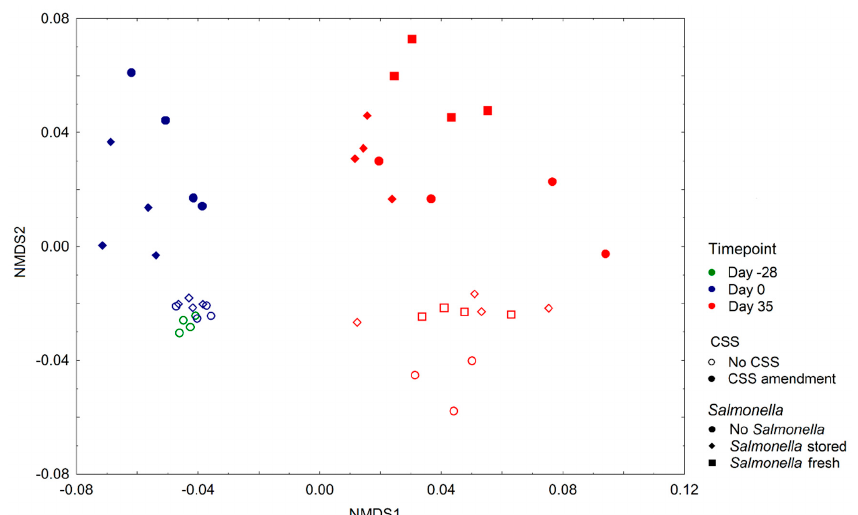
Figure 3. Beta diversity between the prokaryotic communities in diluvial sand (DS) soil. The non-metric multidimensional scaling (NMDS) analysis of the microbial community and analysis of similarities (ANOSIM) were performed according to the sampling timepoint (green: mixing day, blue: planting day, red: 35 days after planting). [ANOSIM] R: 0.85035; p -value < 0.001, [NMDS] stress = 0.096213, sludge amendment (empty: without sludge, solid color: sludge amended) [ANOSIM]. R: 0.36323; p -value < 0.001, [NMDS] stress = 0.096213 and Salmonella enterica presence (circles: no Salmonella enterica , diamonds: Salmonella enterica introduced via fertilizer, squares: Salmonella enterica introduced via irrigation) [ANOSIM]. R: 0.095536; p -value < 0.036, [NMDS] stress = 0.096213. p -values ≤ 0.05 were considered significant.